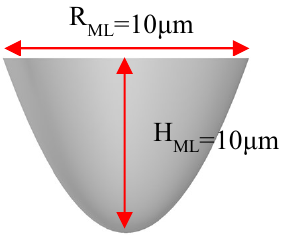
Figure 10. Parabel-surface MLA (PSMLA) microstructure. The distance between the upper and lower PSMLAs (X pitch ) and the left and right PSMLAs (Y pitch ) was 15 and 15 µ m, respectively. The cover rate was calculated